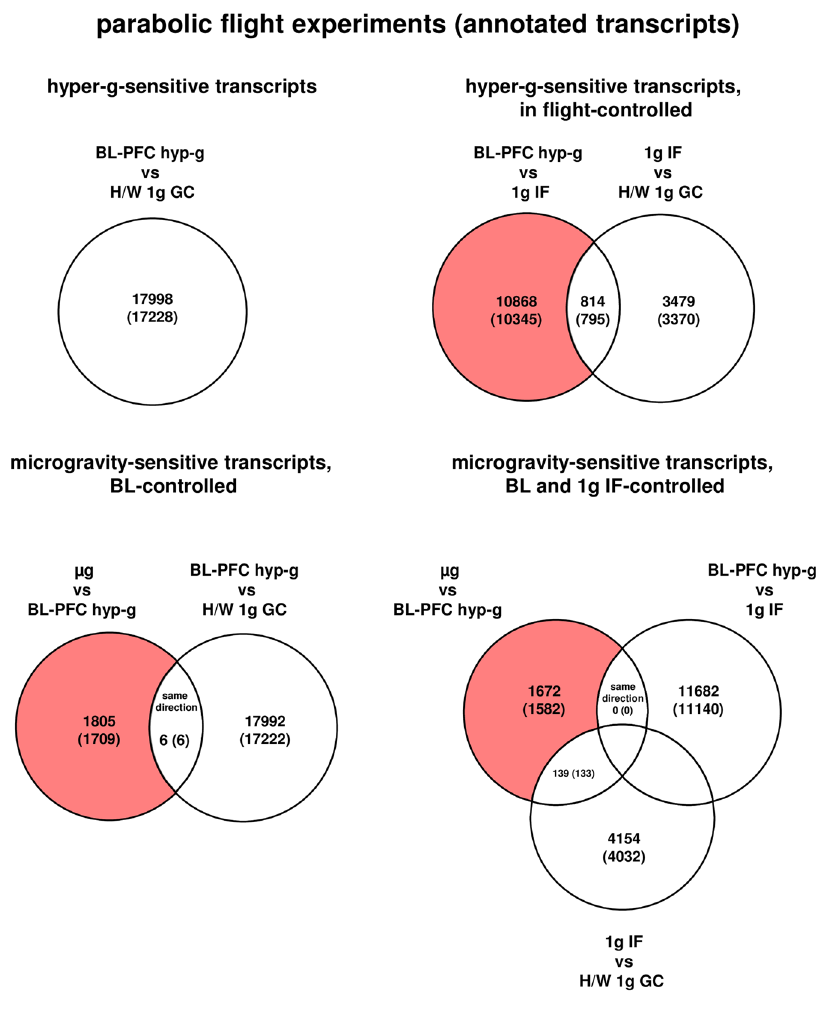
Figure 2. Differentially regulated transcripts (and annotated transcripts) in human U937 myelomonocytic cells during the 19 th DLR Parabolic Flight Campaign. The different comparisons and resulting intersections for hypergravity and microgravity-sensitive transcripts are displayed. Fold change ≤− 1.3 and ≥+ 1.3, p <